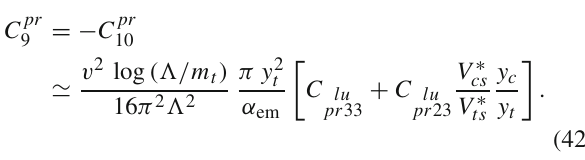
Fig. 2 Diagrams contributing to O ( 1 ) running of O lu . Only the contributions proportional to Yukawa cou- plings are shown, and flavour indices are denoted by p , r , s , t . Below the EWSB scale, these diagrams induce contributions to the b → s (cid:2)(cid:2) transition and to Z -boson couplings to leptons, respectively